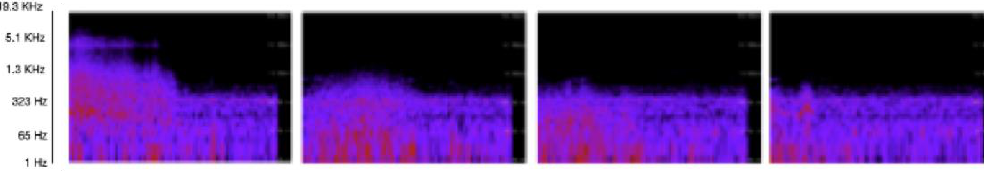
Figure 7. Audio frequency spectra for audio samples of simulated inspirations.